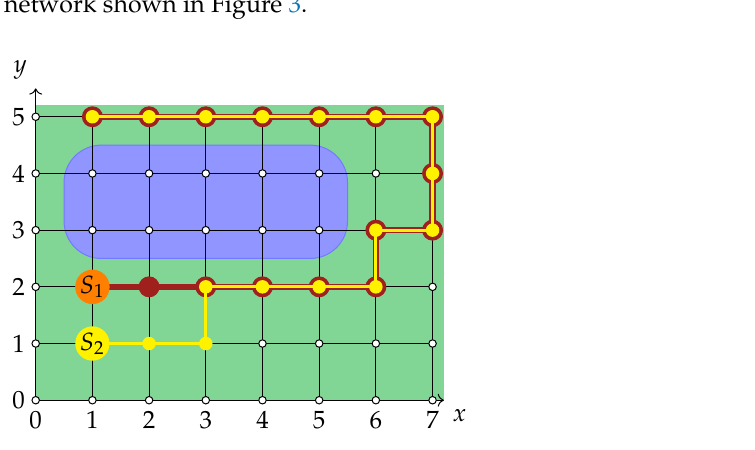
Figure 3. Initial position of the network. Sub-graph diameters D ( R 1 ) = 15 and D ( R 2 ) = 16. There, two sets of agents, indicated by dark red and yellow circles, form two